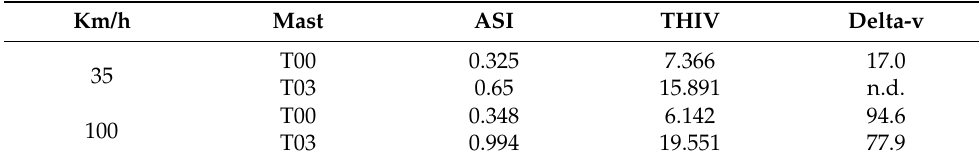
Table 4. Experimental tests results.